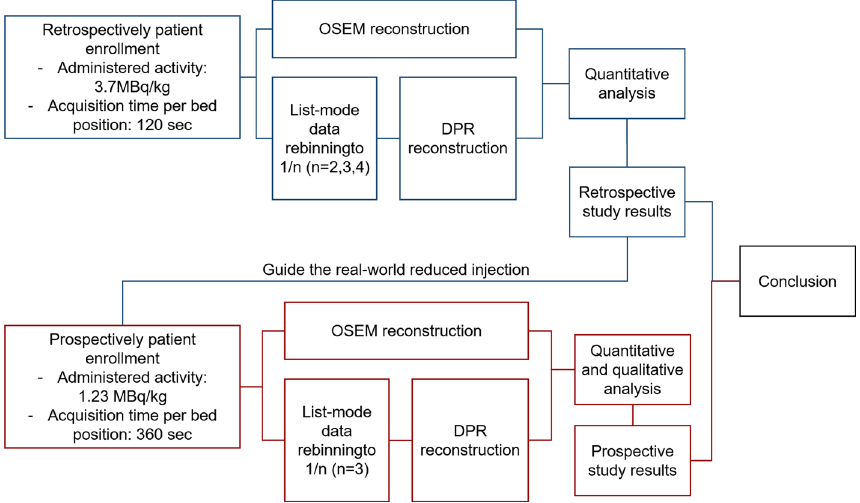
Fig. 1 Flow diagram of the reconstruction process and analysis. OSEM, ordered subset expectation maximization algorithm. DPR, deep progressive learning